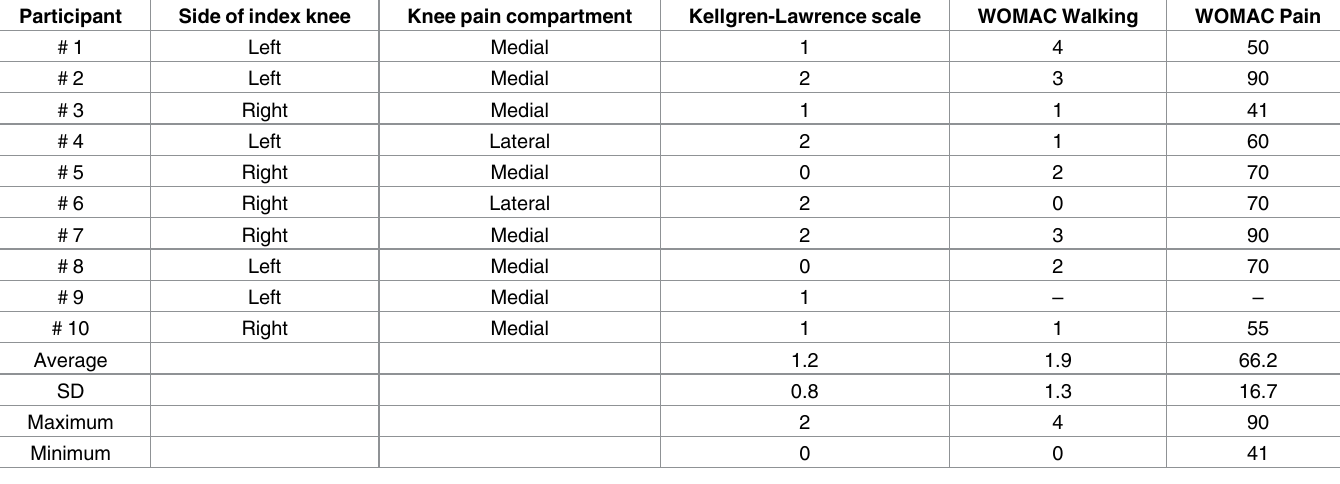
Table 1. Side of index knee, the knee pain compartment, X-ray findings, and WOMAC